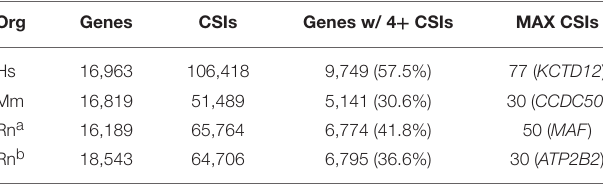
TABLE 4 | Summary of CSIs detected for human, mouse, and rat genome assemblies.